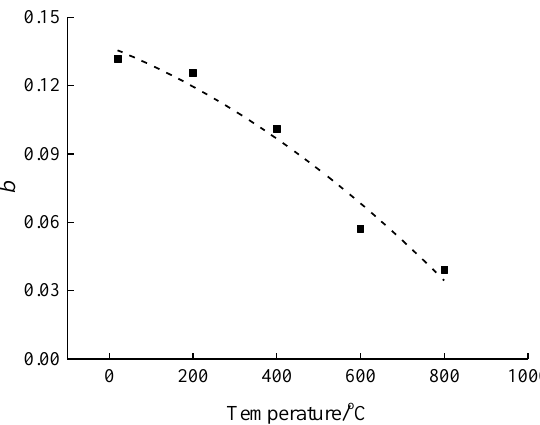
Figure 12. The relationship between temperature and parameter b .